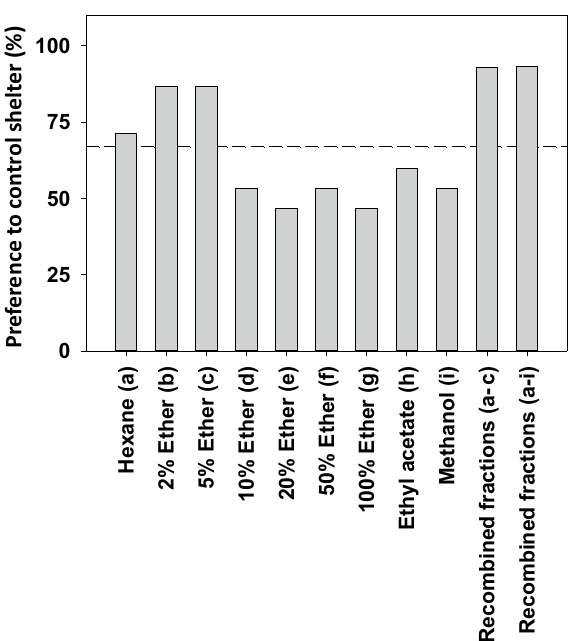
Figure 5. Response of bed bugs in fractionated (SPE) human skin swab extracts. Bed bug preference for the control shelter is reported from the screening assays. Fractions in which > 67% of bed bugs chose the control shelter were evaluated further. Except in hexane and the recombined fractions (a–c; non-responders = 6.66%), all bugs made a choice (100% response rate). In total, 15 insects were used for each fraction